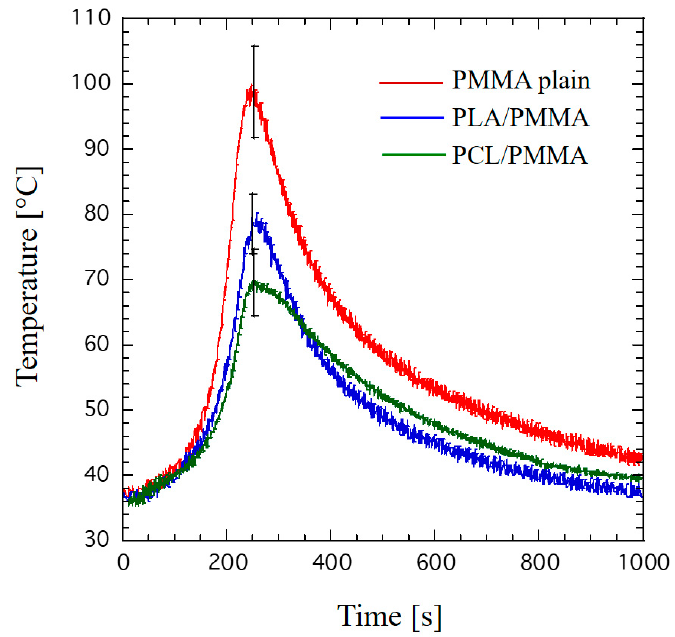
Figure 8. An example of temperature profiles: plain bone cement, PLA and PCL structures infiltrated with PMMA, evidencing some differences during the cooling phase.